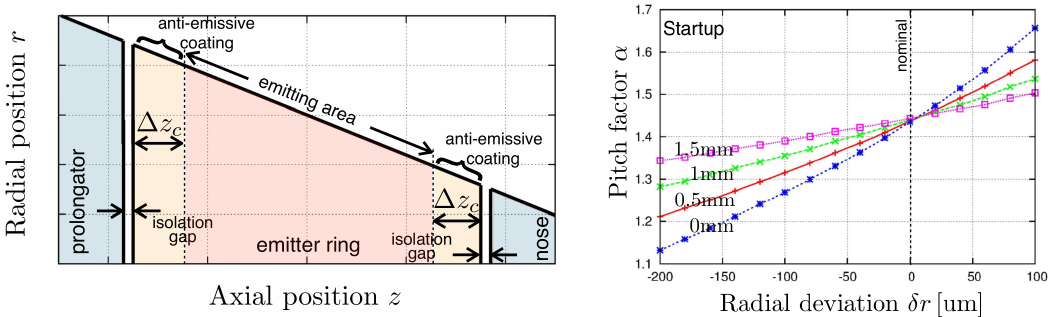
Figure 3. The new type of the emitter ring with coated edge rims (left). The variations of the average pitch factor α as a function of the radial deviation δ r for several values of the coating length ∆ z c (right).